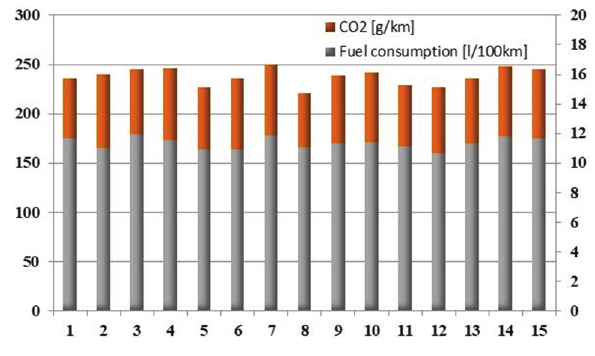
Fig. 6. Fuel consumption and carbon dioxide emissions In order to more reliably confirm the representativeness of the obtained tests, during the tests mass measurement